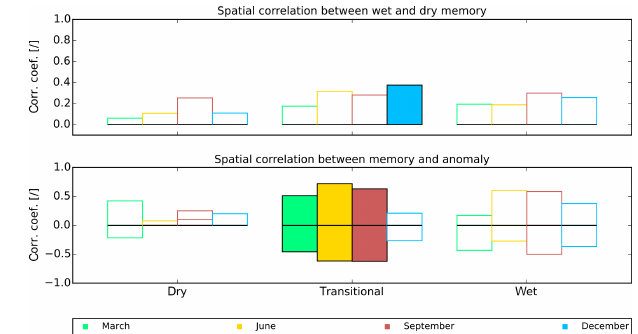
Figure 8. Bar plot for different soil moisture regimes and seasons, indicating correlation coefficients for spatial rank correlations. The upper panel shows the correlation between the pattern of wet τ 0 and dry τ 0 . The lower panel shows the correlation between the pattern of wet and dry τ 0 and the respective (cid:49)θ 0 . Significant correlations below the 5% level are indicated by solid